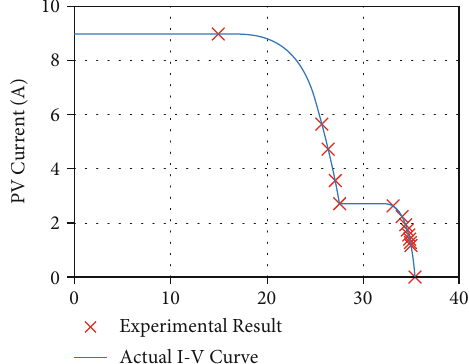
Figure 13: I-V characteristics for 20% partial